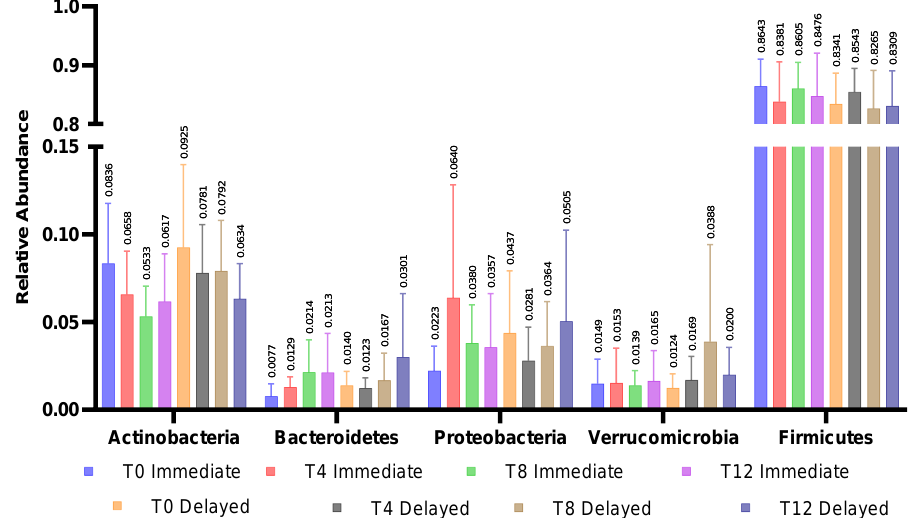
Figure 2. Relative abundance of 5 major phyla within groups across all time points. No significant differences were observed between the immediate and delayed groups within phyla or across timepoints within phyla.